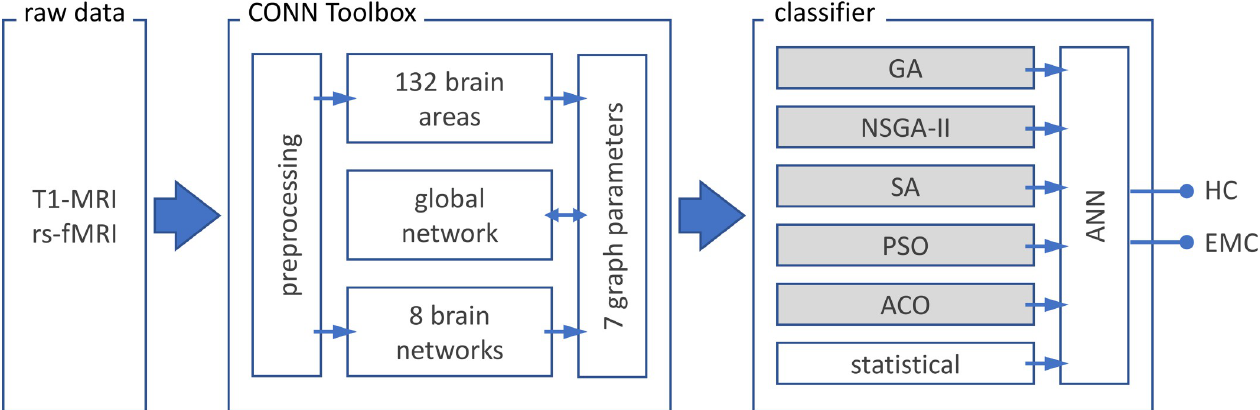
Fig 1. Procedure of the proposed method. T1-MRI (sMRI) and resting-state fMRI (rs-fMRI) data of healthy participants (HC; n = 72) and patients with early mild cognitive impairment (EMCI; n = 68) are extracted from ADNI database 82 . Preprocessing, parcellation of brain area (132 regions based on AAL and Harvard-Oxford atlas) and extraction of the functional connectivity (8 network parameters with a total of 32 nodes), as well as the 7 graph parameters are done using CONN toolbox 84 . Subsequently the global network is calculated based on the network parameters. The 1155 ([132 brain regions + 32 nodes of brain networks + 1 global network] × 7 graph parameters) extracted parameters are given to one of the optimization methods to select the best subset of parameters that lead to best classification method. Optimization methods consisted of five evolutionary algorithms (boxes with grey shading) and one statistical algorithm. The outputs of these methods are given to an artificial neural network (ANN) with two hidden layers to classify the data into HC and EMCI. AAL: Automated anatomical atlas; GA: Genetic algorithm; NSGA-II: Nondominated sorting genetic algorithm II; ACO: Ant colony optimization; SA: Simulated annealing; PSO: Particle swarm optimization; seven graph features: Degree centrality, betweenness centrality, path length, clustering coefficient, local efficiency, cost and global